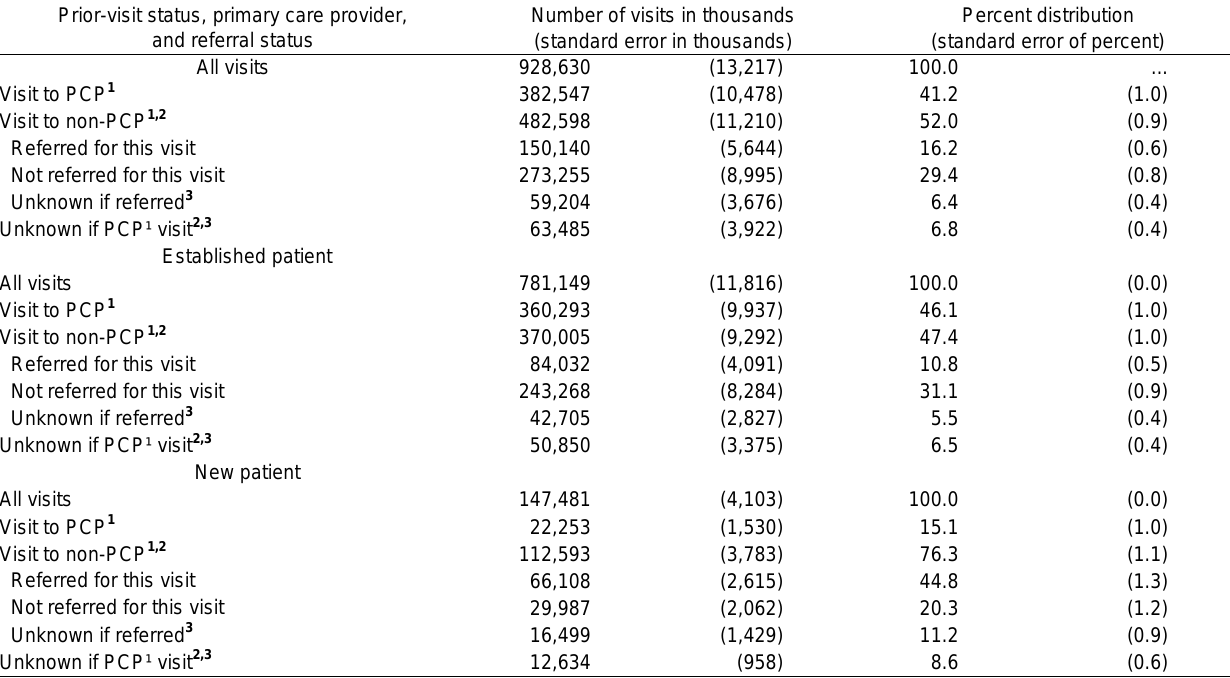
Table 8. Primary care provider and referral status of office visits, by prior-visit status: United States,